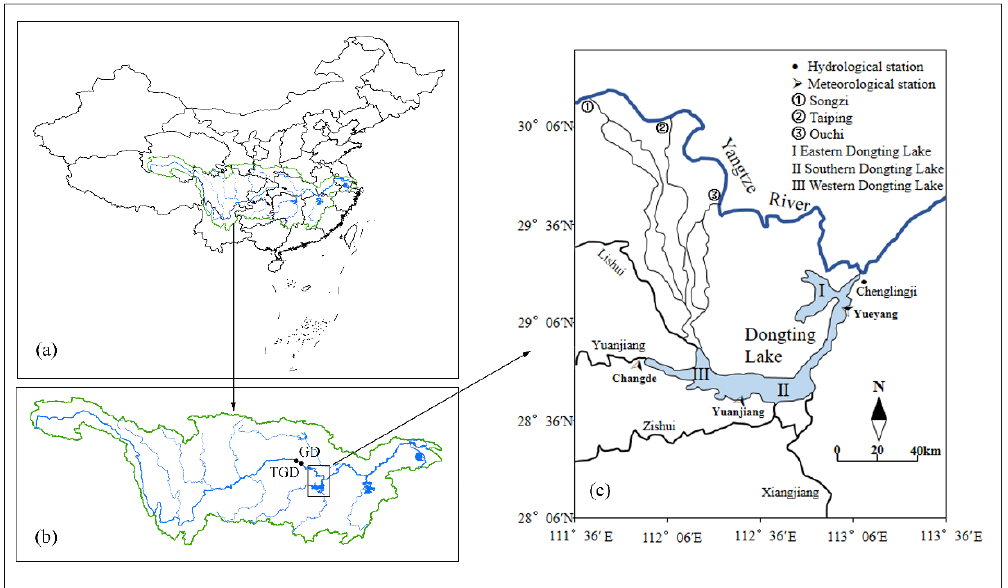
Figure 1. Location of the study region. ( a ) location of the Yangtze River Basin in China; ( b ) the Yangtze River Basin: location of the TGD, the GD, and the Dongting Lake; ( c ) the Dongting Lake: location of the hydrological station and meteorological station.